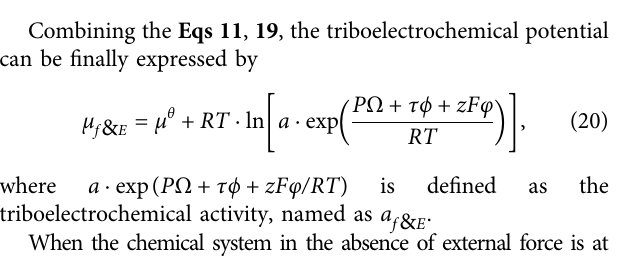
Frontiers in Chemistry |